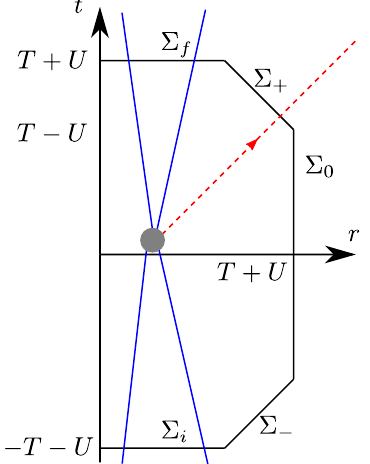
Figure 1 . The region where we consider the current conservation. The directions along the two sphere S 2 are suppressed in this (cid:12)gure. The blue lines represent trajectories of massive charged particles, which scatter at a small region. The red line represents a direction of the radiation emitted from this scattering. The region is parametrized by two parameters T and U . The parameter T is so large that all of the given massive particles go through the surface (cid:6) i and (cid:6) f , and U is also so large that any radiation coming from the scattering region passes through (cid:6) +